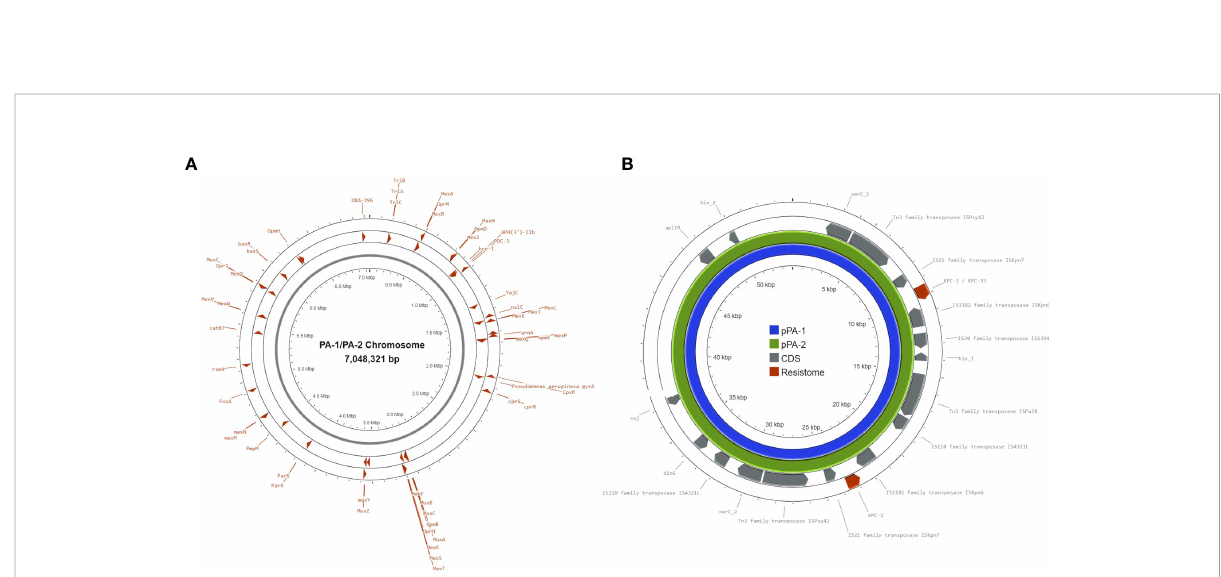
FIGURE 3 Chromosomes of isolates PA-1 (A) and PA-2 (B) and plasmids pPA-1 and pPA-2 C. Red arrowheads in A and B represent genes that are associated with antimicrobial resistance. The resistome of plasmids pPA-1 and pPA-2 C is composed only by two bla KPC-2 genes in pPA-1 and both bla KPC-2 and bla KPC-33 genes in pPA-2. Grey bars represent coding sequences (CDS) whose gene names are shown for annotated genes or not shown for hypothetical proteins (hp). Transposase genes: associated with transposition events; hin_1, hin_2, dinG, soj: genes associated with DNA processing and repair; xerC: gene associated with plasmid replication